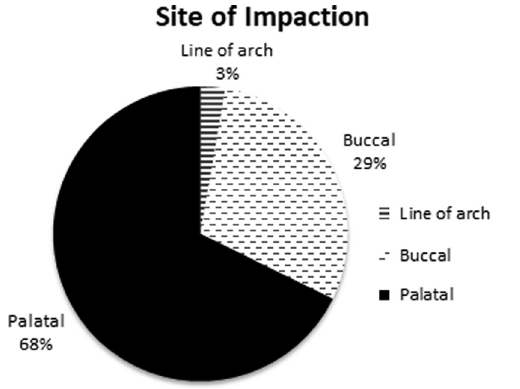
Figure 4. Distribution of canine impaction sites.